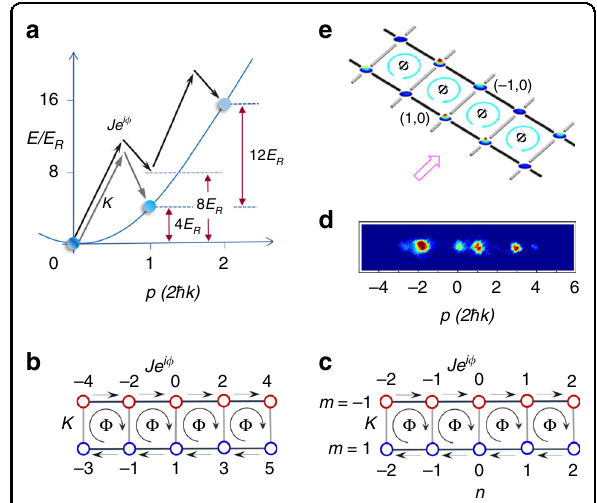
Fig. 2 Synthetic noninteracting two-leg ladder with tunable gauge fi elds. a Illustration of atomic energy diagram and the controllable couplings between discrete momentum states. Bragg transitions with two- and four-photon processes are used to couple the nearest-neighbor (NN) and next-nearest-neighbor (NNN) momentum states, respectively. b A two-leg ladder geometry with 2 × 5 sites is obtained by selectively controlling the NN and NNN couplings in a noninteracting 1D momentum-state lattice. J e i ϕ and K represent the intra- and inter-leg hopping rates. Φ = 2 ϕ . is synthetic magnetic fl ux and can be directly tuned by varying the tunneling phases in the legs. c The lattice sites in (b) are re-encoded to give the coordinates ( m, n ) in a two-leg ladder. d The absorption image after 18 ms time of fl ight shows the density distribution of atoms with different momenta in one dimension. e Population of atoms in the synthetic two-leg ladder can be extracted through the connection of the different momentum states to the re-encoded lattice sites ( m, n